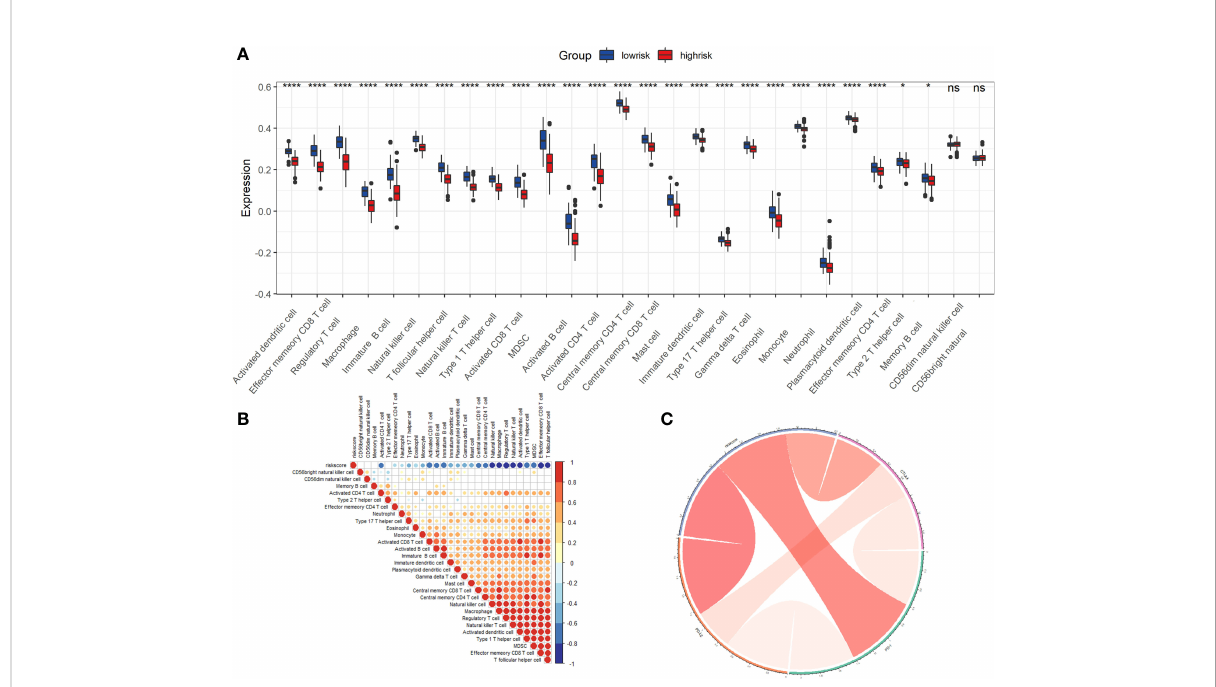
FIGURE 8 The role of riskScore signature in the TME cell in fi ltration and immunotherapeutic responses. (A) Differences in 28 TME in fi ltration cells between low and high risk groups ns, not signi fi cant, * P <0.05, **** P <0.0001. The results demonstrated that most TME cells (26 types) exist signi fi cant differences. (B) The correlation between riskScore signature and 28 TME cell in fi ltration. Color shades represent the strength of the association, blue represents negative correlation and red represents positive correlation. (C) The correlation between riskScore signature and immune checkpoint molecules. Blue represents negative correlation and red represents positive correlation. ns, not signi fi cant.